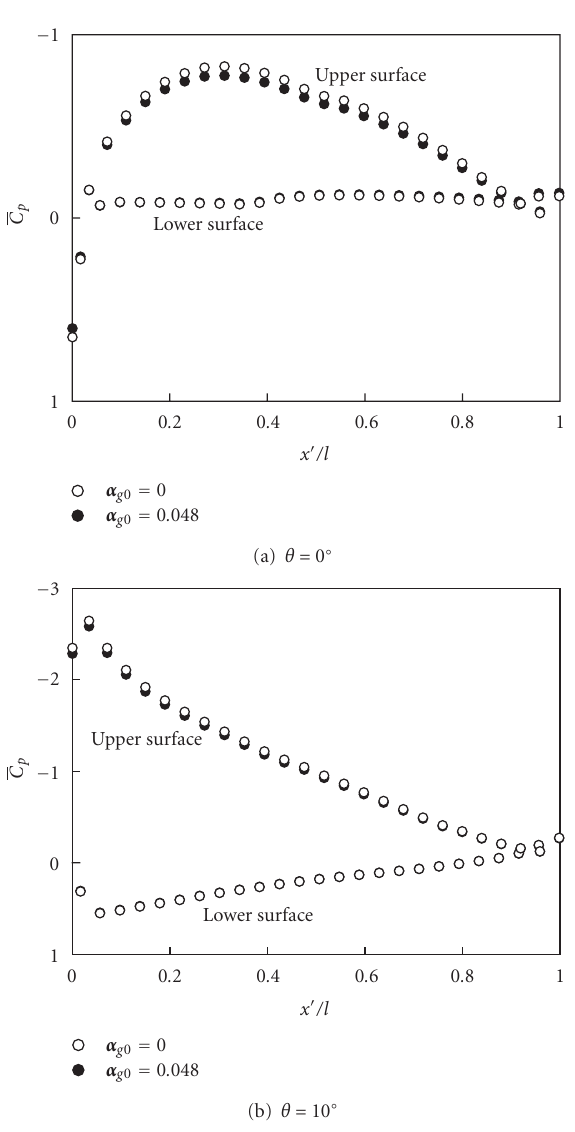
Figure 11: Pressure distribution on